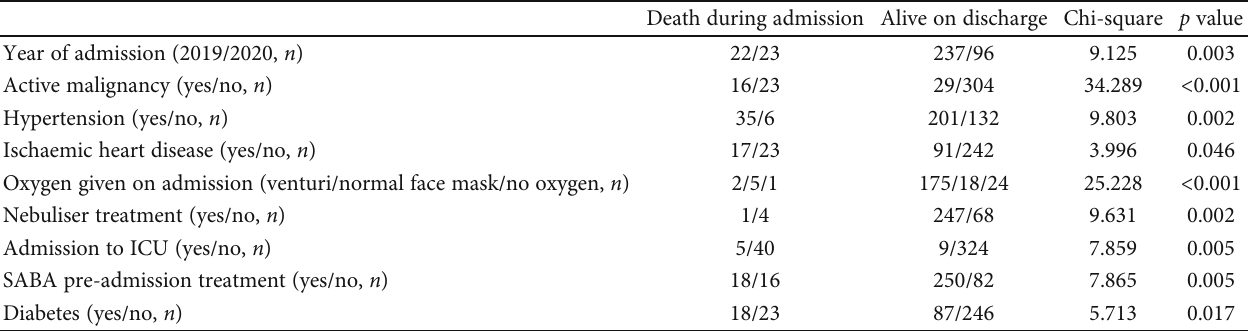
Table 5: Categorical variables that were signi fi cantly related with inpatient mortality (analysed using the chi-square test). Death during admission Alive on discharge Chi-square p